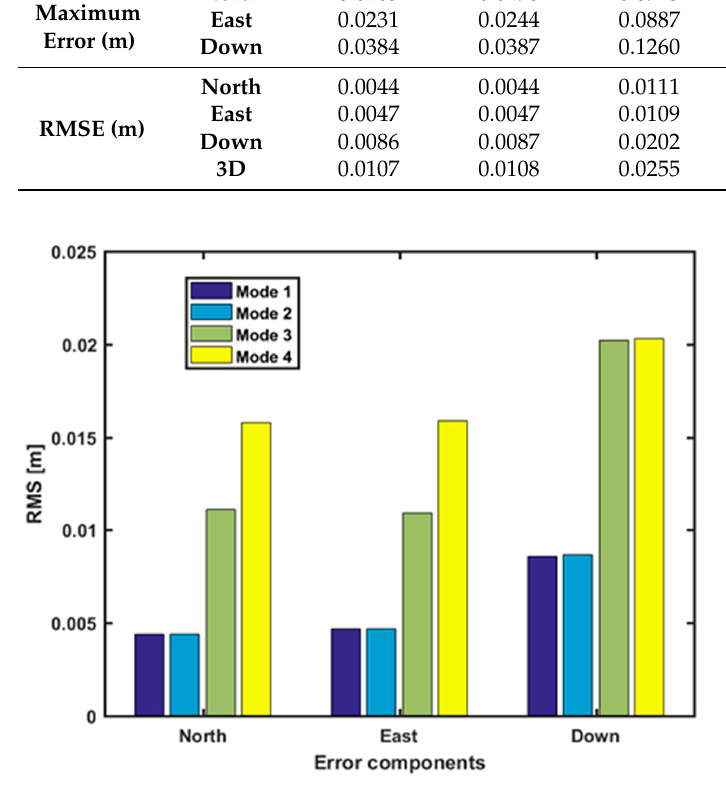
Figure 16. Comparison of relative position errors in modes 1–4 in test 1. Compared with mode 1, mode 2 only significantly decreases the broadcast rate of raw GNSS observations from 10 Hz to 1 Hz, while leaving other parameters